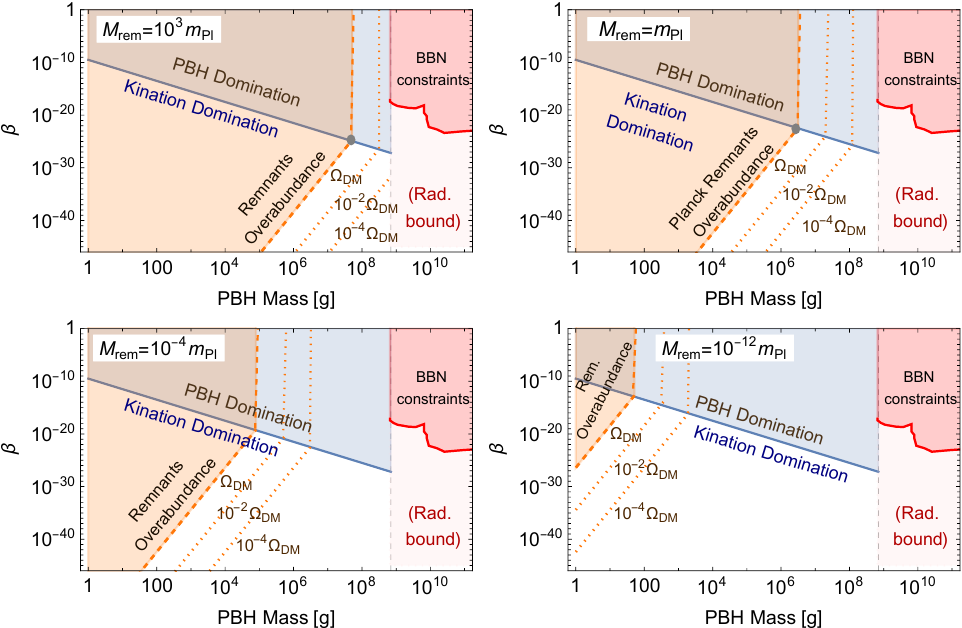
Figure 4. In each panel the white and colored regions depict the parameter space that gives viable cosmology without overabundance of remnants. The four panels correspond to four different remnant masses M rem / m Pl = 10 3 ,1,10 − 4 ,10 − 12 , respectively. The orange dotted lines give the ( M PBH , β ) values that realize the PBH remnant dark matter scenario and on the dashed line the Ω DM bound is